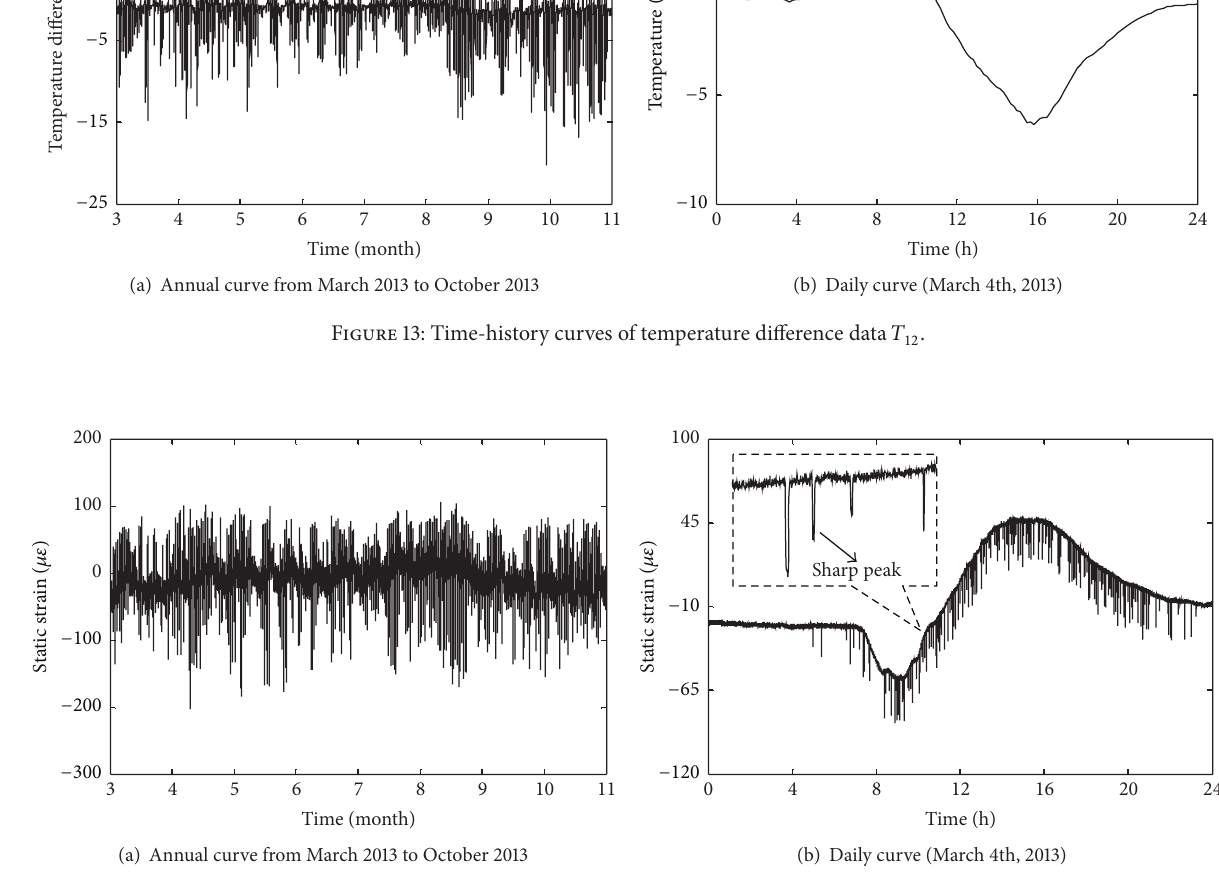
Figure 14: Time-history curves of static strain data 𝑆 1